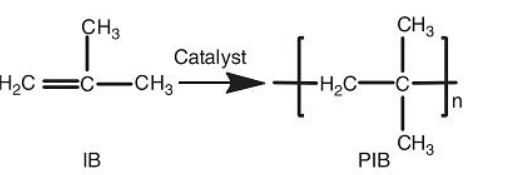
Figure 20. Scheme of the polymerization of isobutylene (IB) to form polyisobutylene (PIB). Adapted from [94].